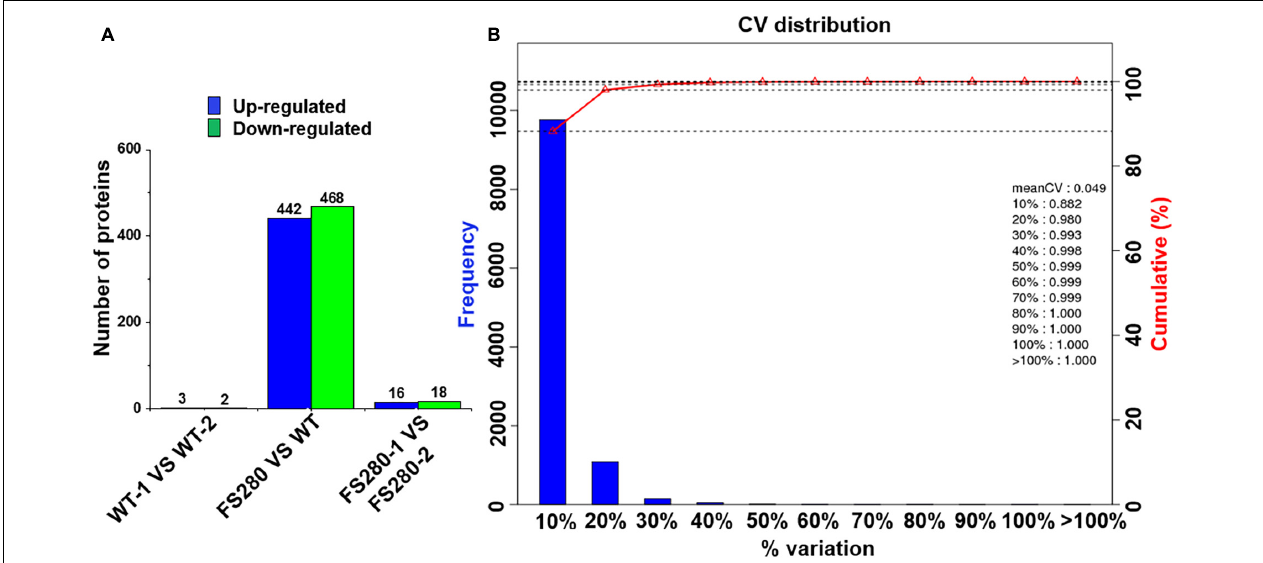
FIGURE 4 | Protein quantification in C. cohnii . (A) Histogram of differentially expressed proteins. (B) Distribution of the CV (coefficient of variation) in replicates. The CV is defined as the ratio of the standard deviation to the mean. The X -axis represents the deviation among the protein ratios of the repetitive samples. The Y -axis represents the percentage of proteins at a certain angle that comprised the quantified amount of protein.